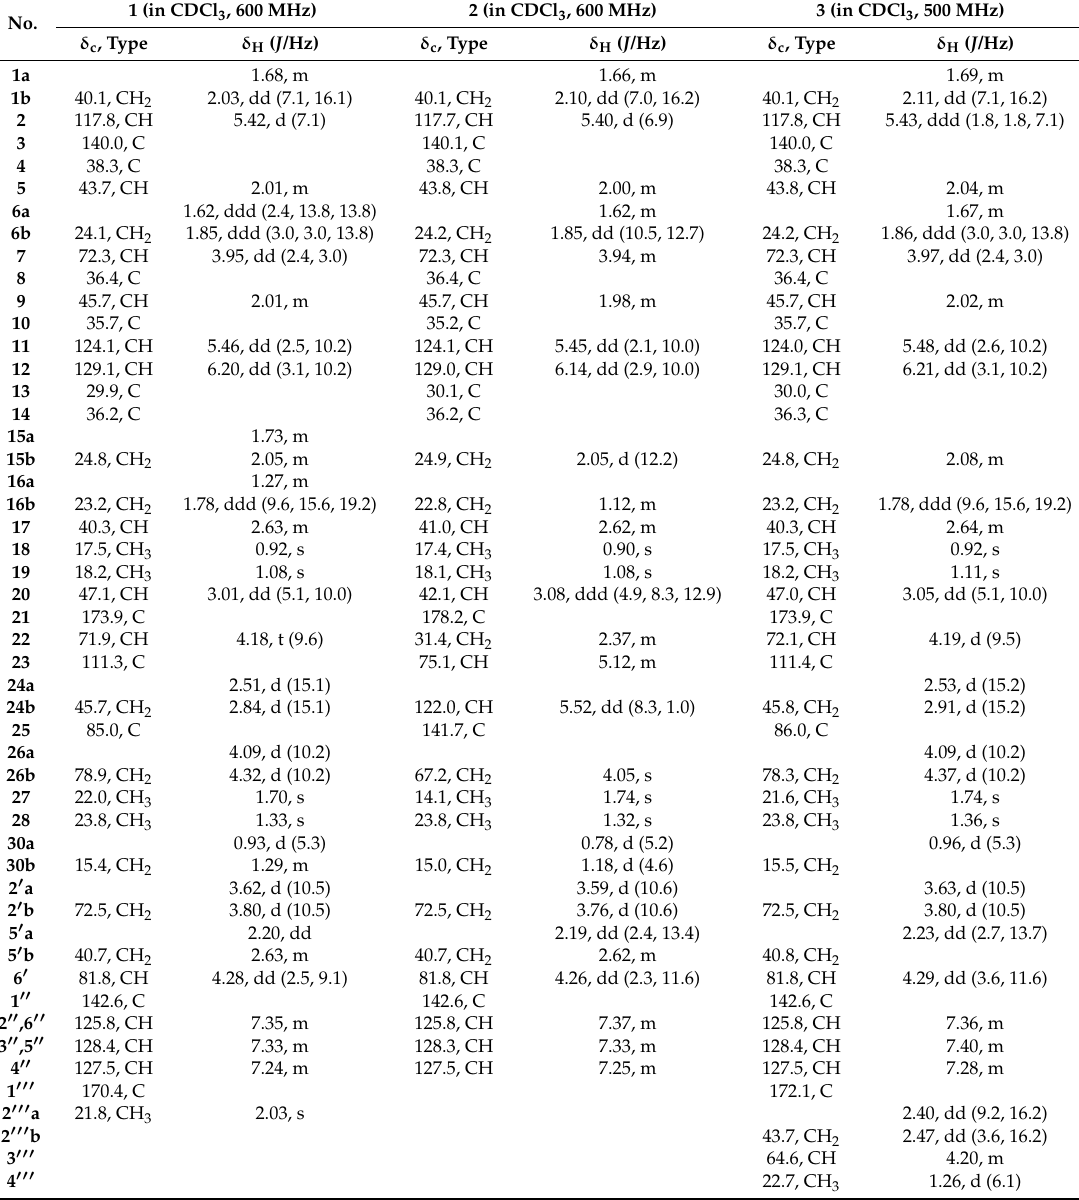
Table 1. NMR spectroscopic data for 7-hydroxydichapetalin P ( 1 ), dichapetalins A ( 2 ) and X ( 3